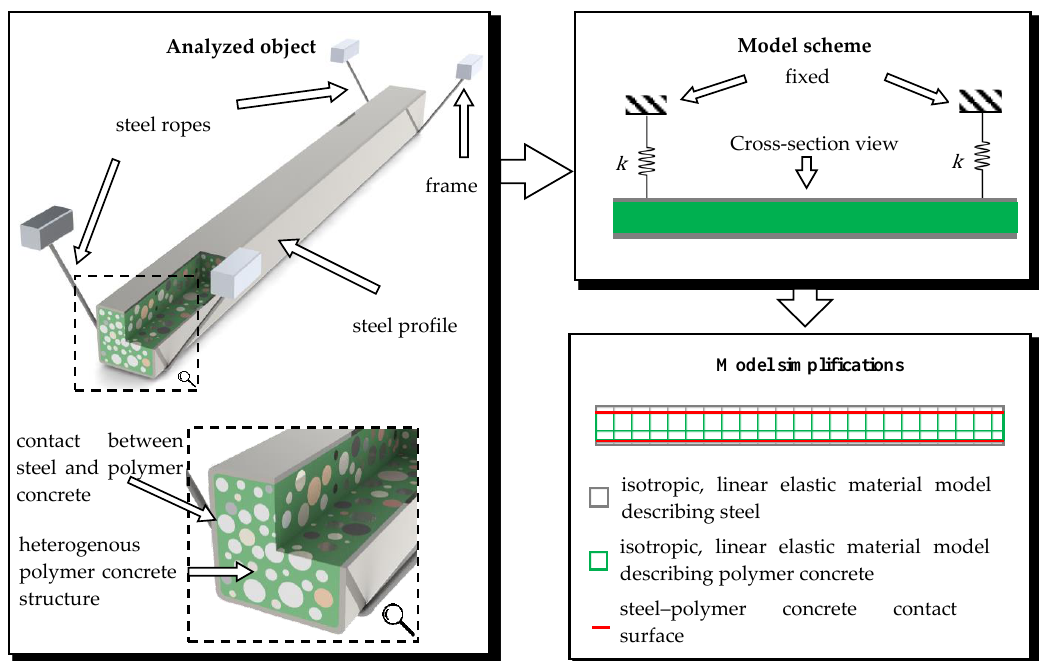
Figure 6. Simplifications applied for the mathematical model of the steel–polymer concrete beam.